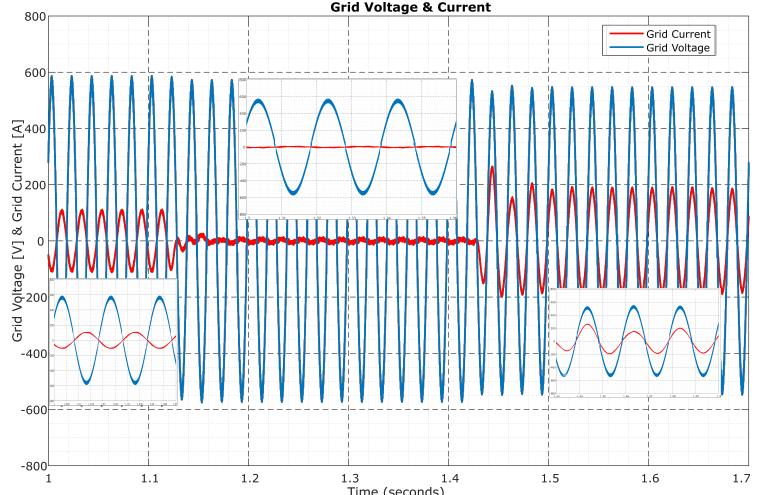
Figure 18. Grid voltage V a and grid current I a [21], © 2021